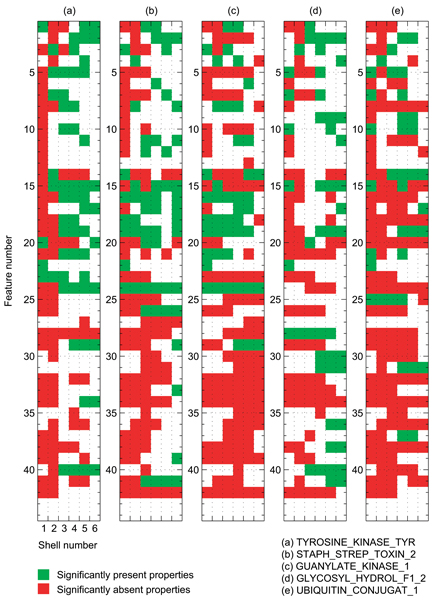
Fingerprints of over- or underrepresented features. This figure presents fingerprints of the features that are over- or underrepresented in each of the five validation clusters described in the text. The descriptions of the features are listed in Table 1. Green cells indicate the features that are significantly overrepresented with respect to the background of all two million feature vectors (P < 0.001). Red cells indicate features that are underrepresented. We used the two-sample test for binomial proportions for p-value computation. The rows and columns correspond to feature numbers (see Table 1) and the shell numbers, respectively.